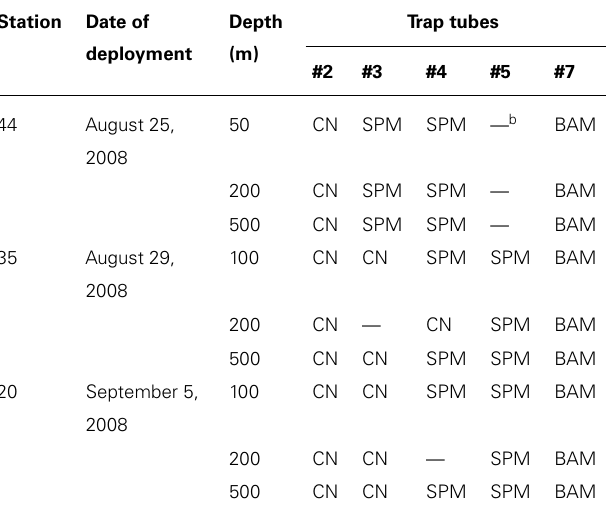
Table 1 | Sediment trap deployments and target assays a from trap tubes in this